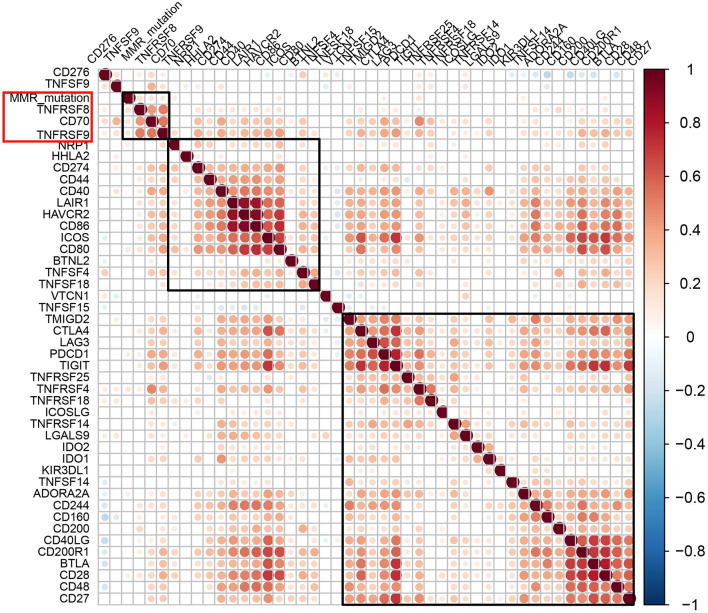
Correlation heatmap between IGCs' expression and mismatch repair (MMR) gene mutation. The blank shows non-significant correlation. Blue represents negative correlation, while red represents positive correlation. The larger the point and the redder the color, the stronger the correlation.